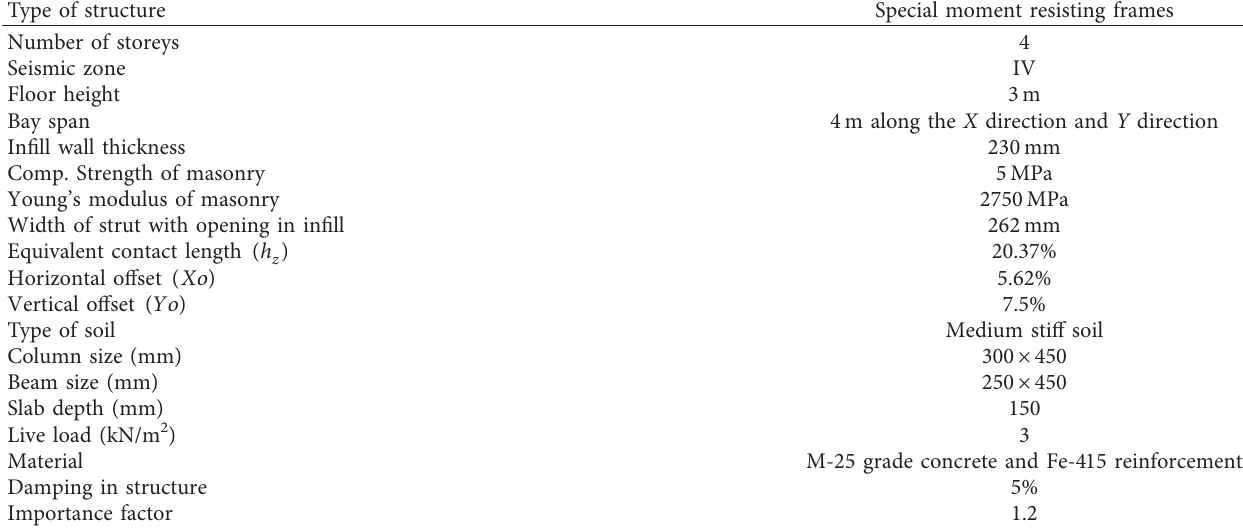
Figure 6: The two models of the building: (a) full RC-infilled frame; (b) open ground storey RC-infilled frame. Table 2: Structural details of the